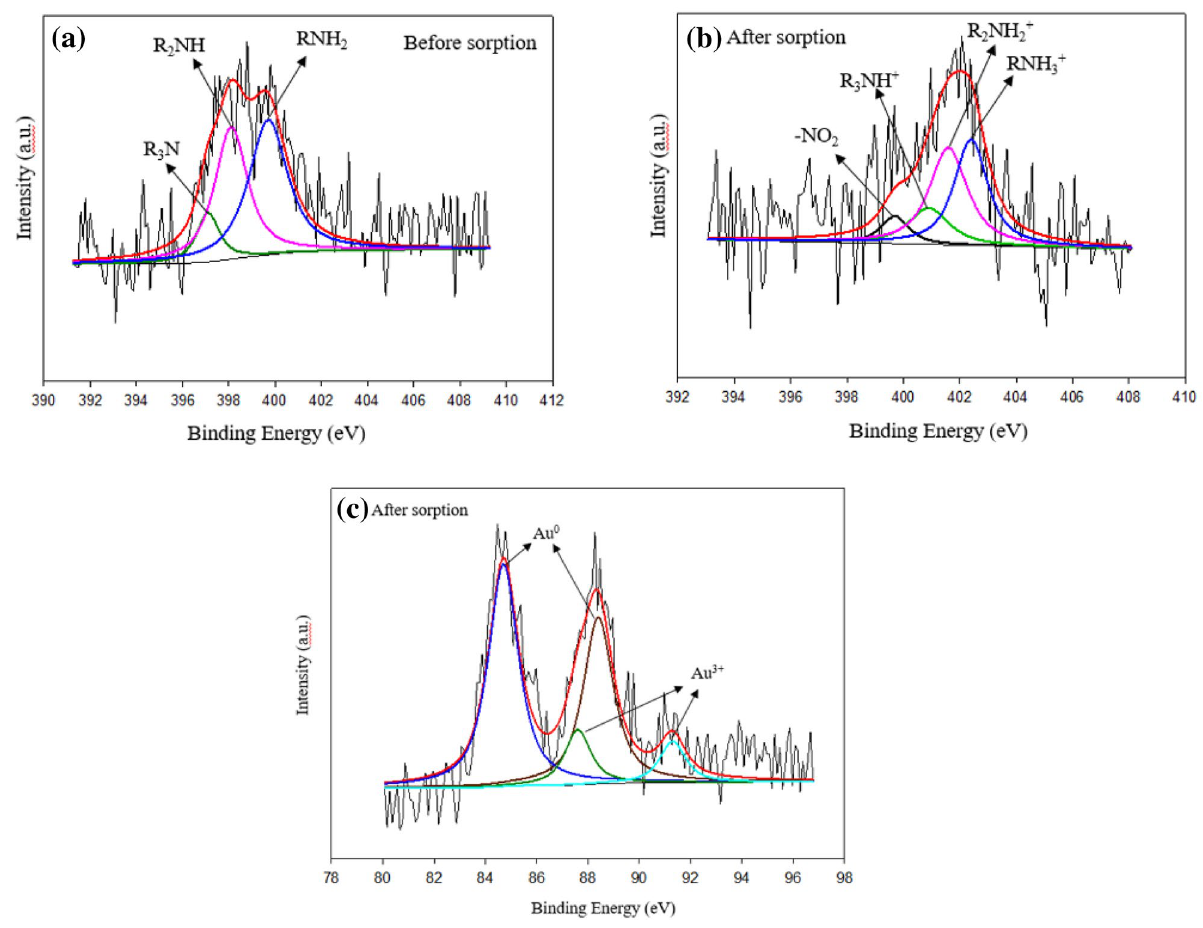
Figure 8. XPS of the capsule ( a ) before sorption, ( b ) after sorption, and ( c ) after sorption of